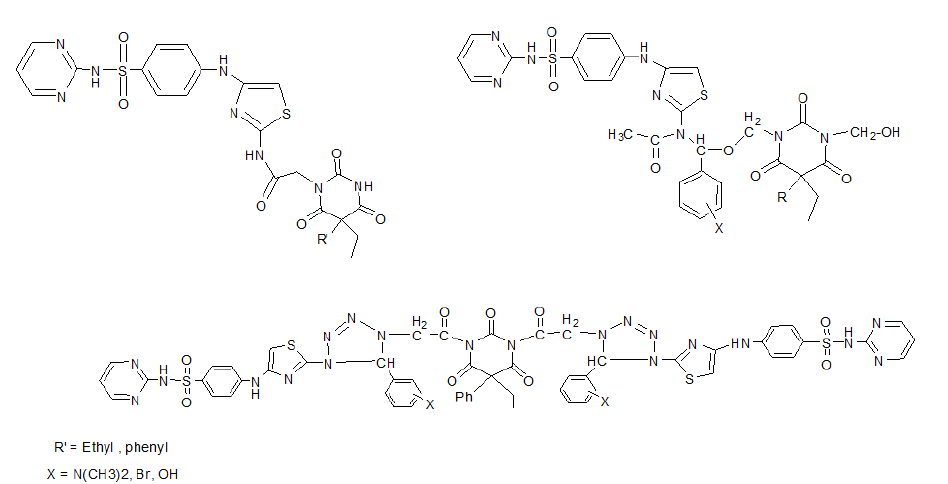
Fig. 4 . Structure of barbituric acid derivatives containing sulfa